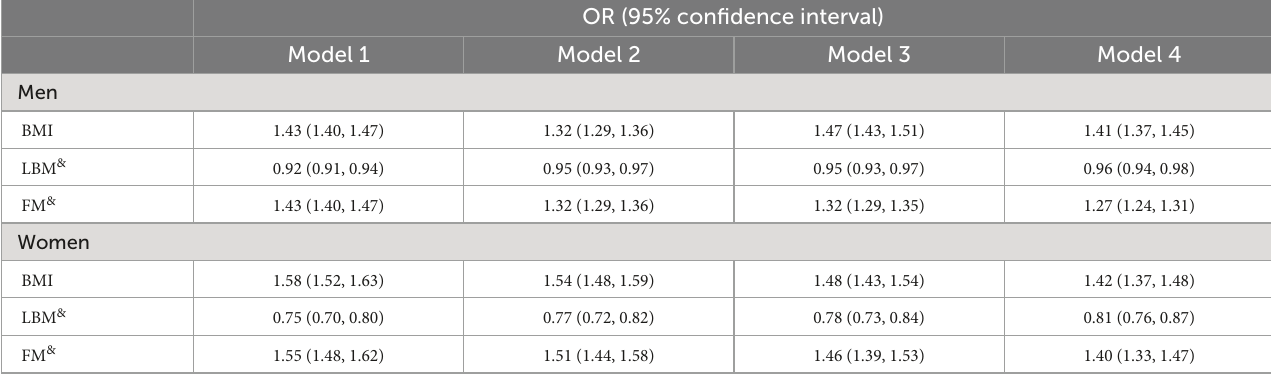
TABLE 3 The odds ratio of associations between predicted fat mass (FM) and lean body mass (LBM) and body mass index (BMI), and non-alcoholic fatty liver disease (NAFLD)